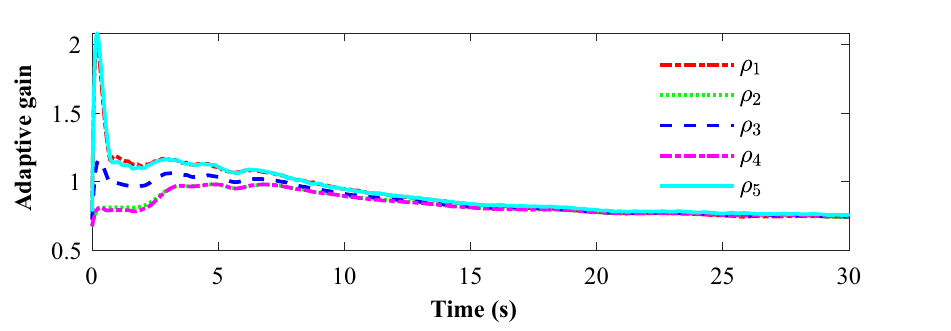
x , y , z coordinate. (cid:31) (cid:30)